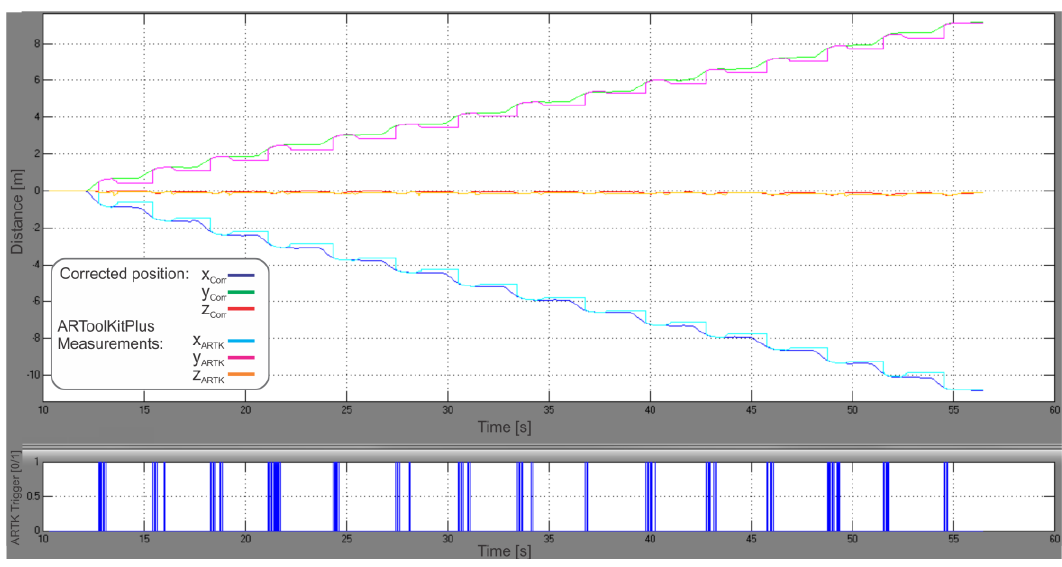
Figure 7. ARToolKitPlus-corrected positional navigation solution. The edgier red, green and dark blue curves are ARToolKitPlus measurements being fed to the UKF at the moments, represented by the blue spikes in the graph